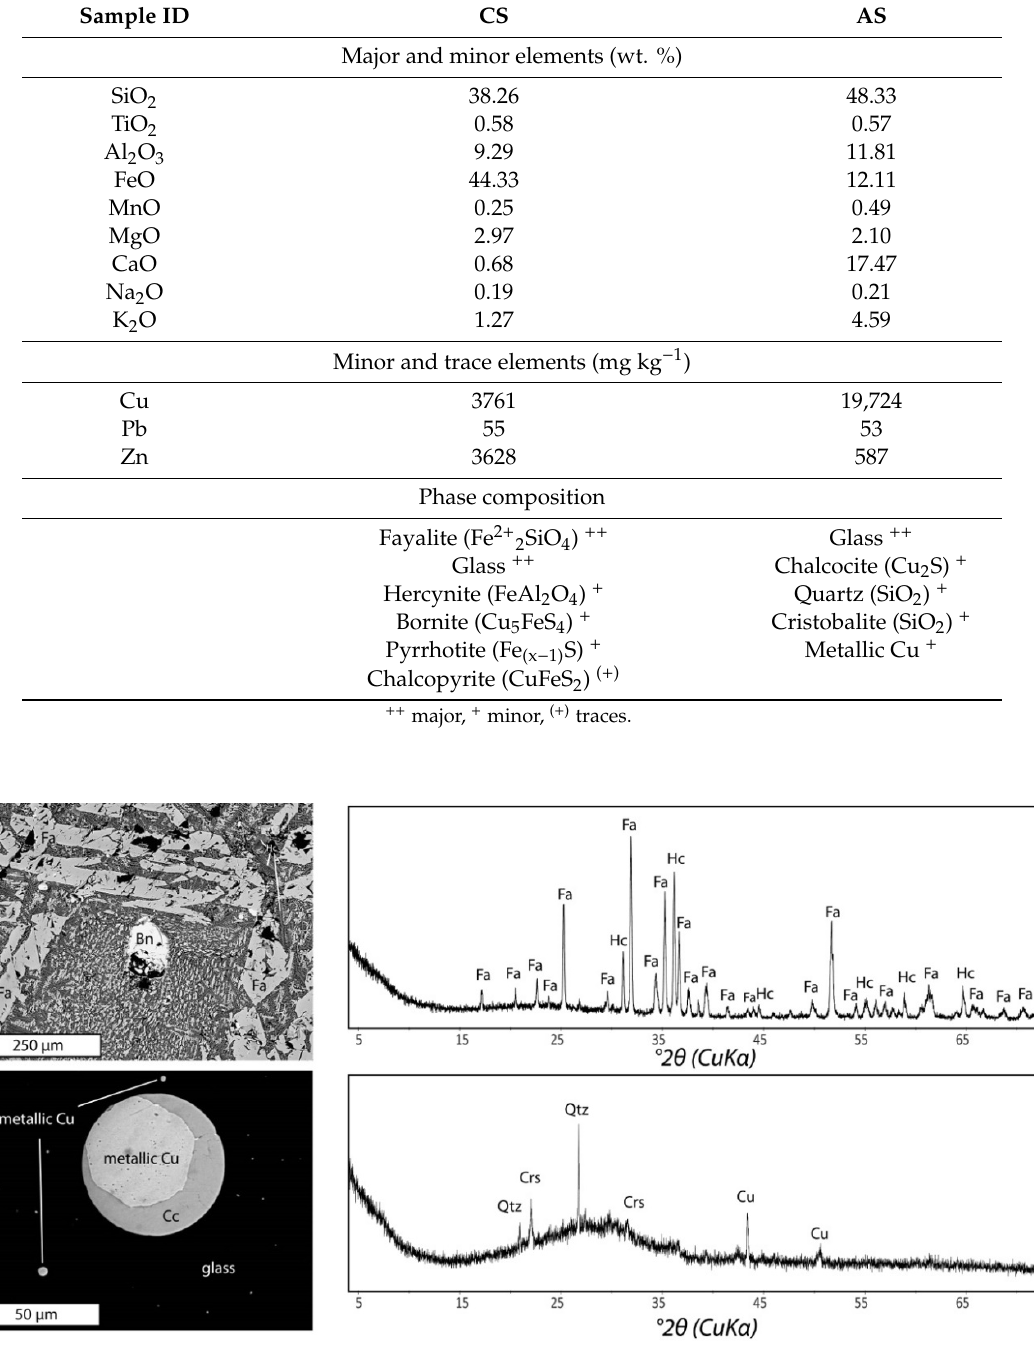
Figure 2. Chemical extraction of metals from crystalline slag treated with sulfuric acid at different concentrations (0.1–1 M) and various pulp densities (1–10%).